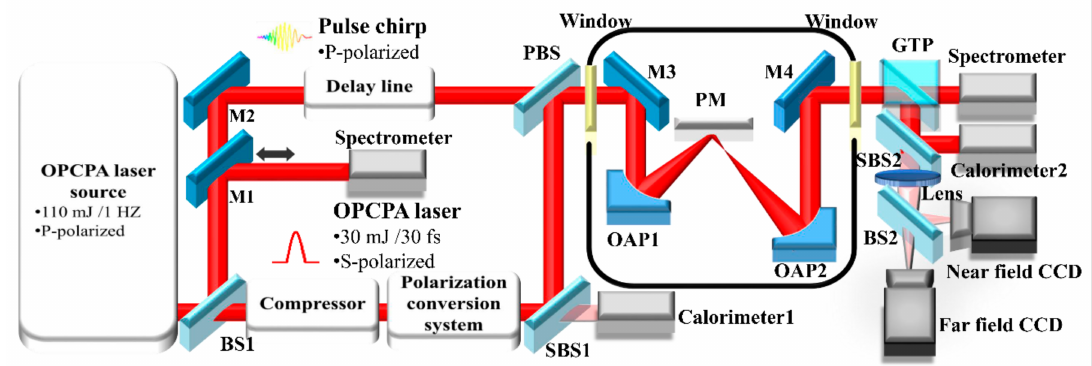
Figure 2. Experimental setup: BS: beam splitter; PBS: polarizing beam splitter; M1–M4: mirror; OAP: Off-axis parabolic mirror; PM: plasma mirror; GTP: Glan-Taylor prism; SBS: sampling beam splitter. A spectrometer is used for measurement of spectrum. A far-field CCD, a near-field CCD, and two calorimeters are used for monitoring the output beam and energy of igniting